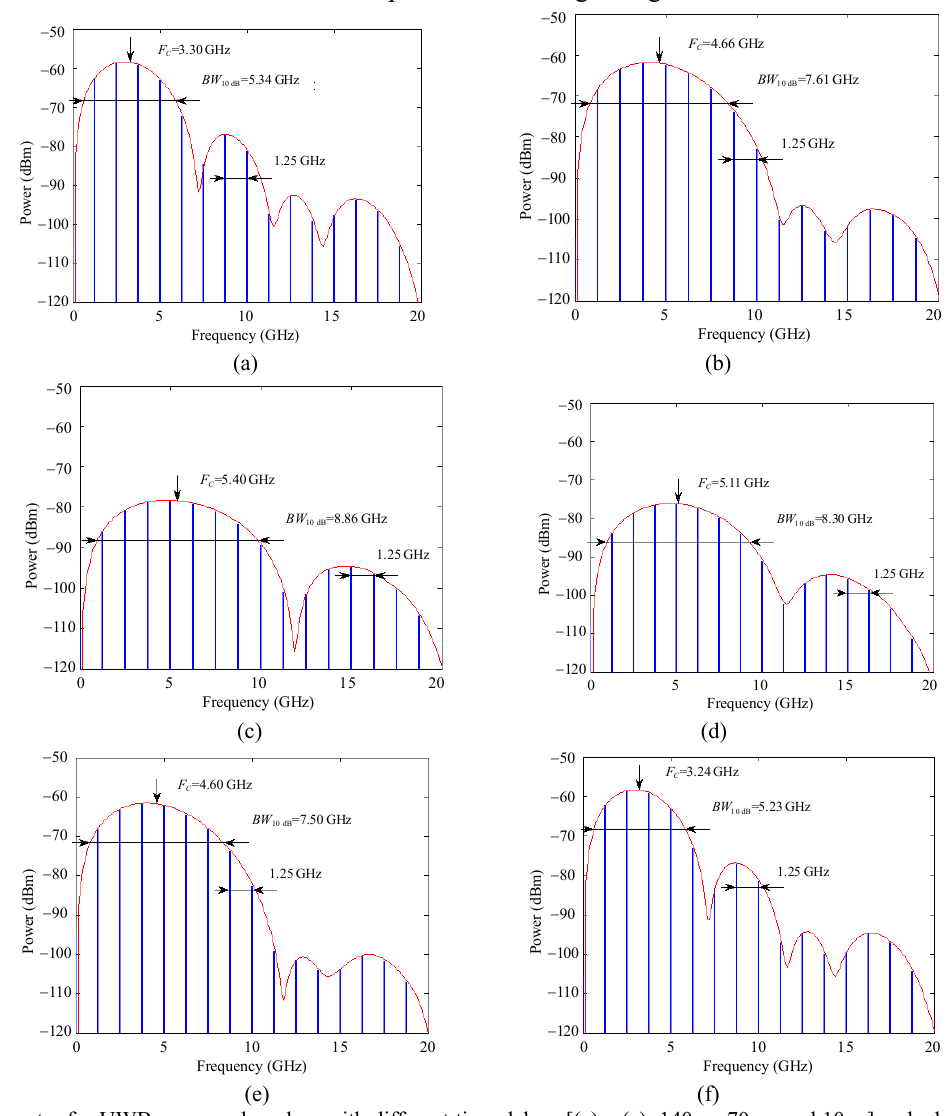
Fig. 5 RF spectra for UWB monocycle pulses with different time delays [(a) ‒ (c): 140 ps, 70 ps, and 10 ps] and advances [(d) ‒ (f): ‒ 10 ps, ‒ 70 ps, and ‒ 140 ps]: (a) ‒ (c) positive UWB monocycle and (d) ‒ (f) negative UWB monocycle.